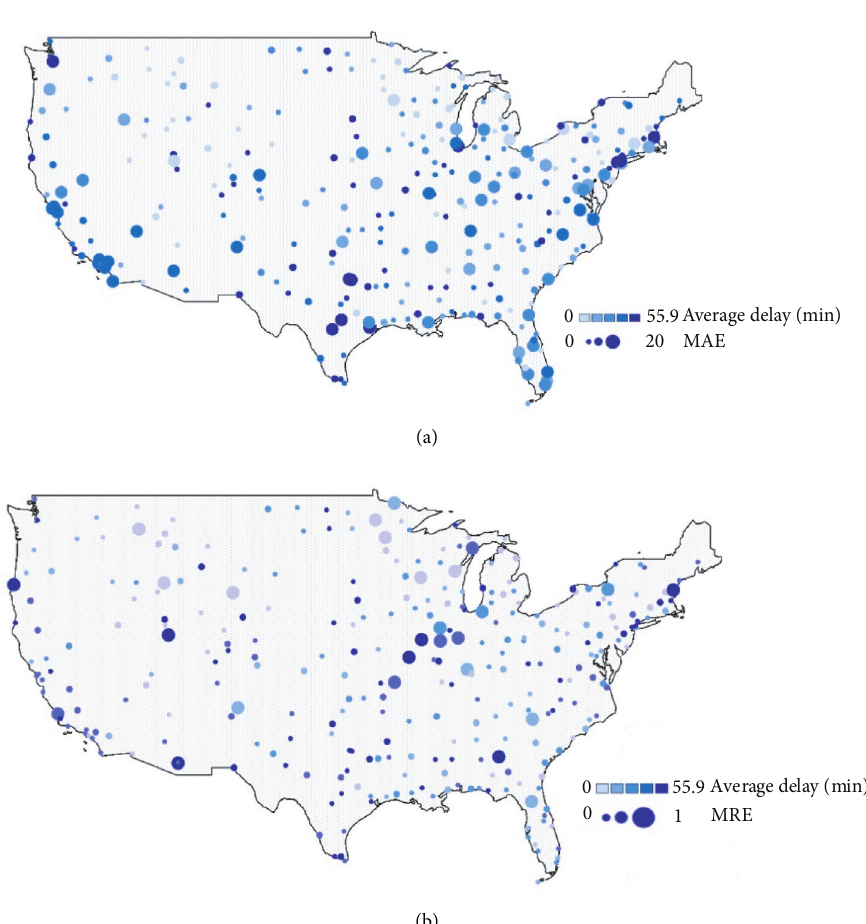
Figure 7: The prediction errors of airports with different delay levels. Color of the ball indicates the degree of airport delay, and the size of the ball means the airport’s MAE and MRE values. (a) Relationship between delay and MAE. (b) Relationship between delay and MRE.